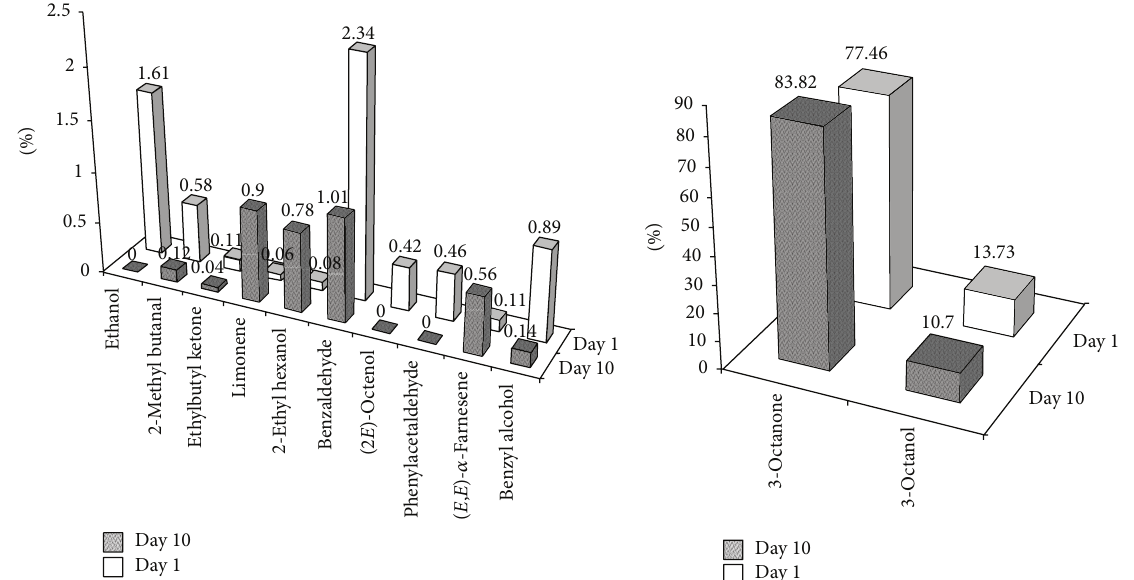
Figure 3: Comparison of the volatile fingerprints of Agaricus bisporus mushrooms. Day 1: fresh samples. Day 10: samples from a 10-day storage period in refrigerator (+6 ∘ C). Data are expressed as FID peak area % and are relative to different batches of samples ( 𝑛 = 3 ), each analyzed in triplicate ( 𝑖 = 3